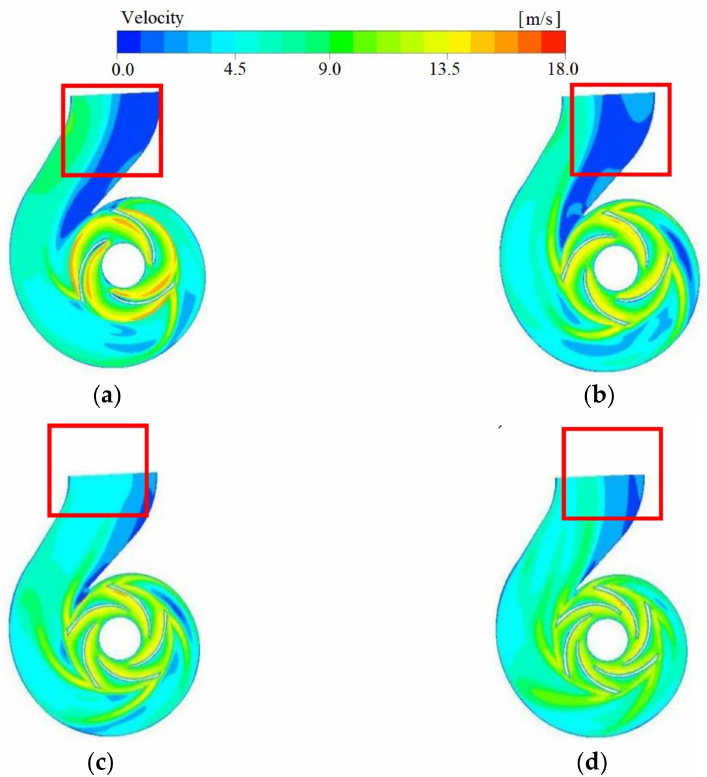
Figure 13. Relative velocity vectors in pump cross-section at different numbers of blades: ( a ) three- blade; ( b ) four-blade; ( c ) five-blade; ( d ) six-blade.